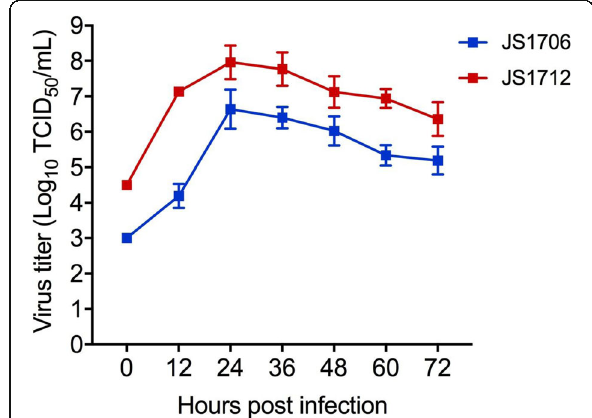
Fig. 3 Growth kinetics of CCoV JS1706 and CCoV JS1712 in A-72 cells. A-72 cells were infected with JS1706 and JS1712 at an MOI (multiplicity of infection) of 0.05. Infected cells and culture supernatant were harvested every 12 h for 72 h. Virus titer was determined by TCID 50 (50% tissue culture infective dose) . Data are representative of three independent experiments performed in triplicate and presented as the means ±